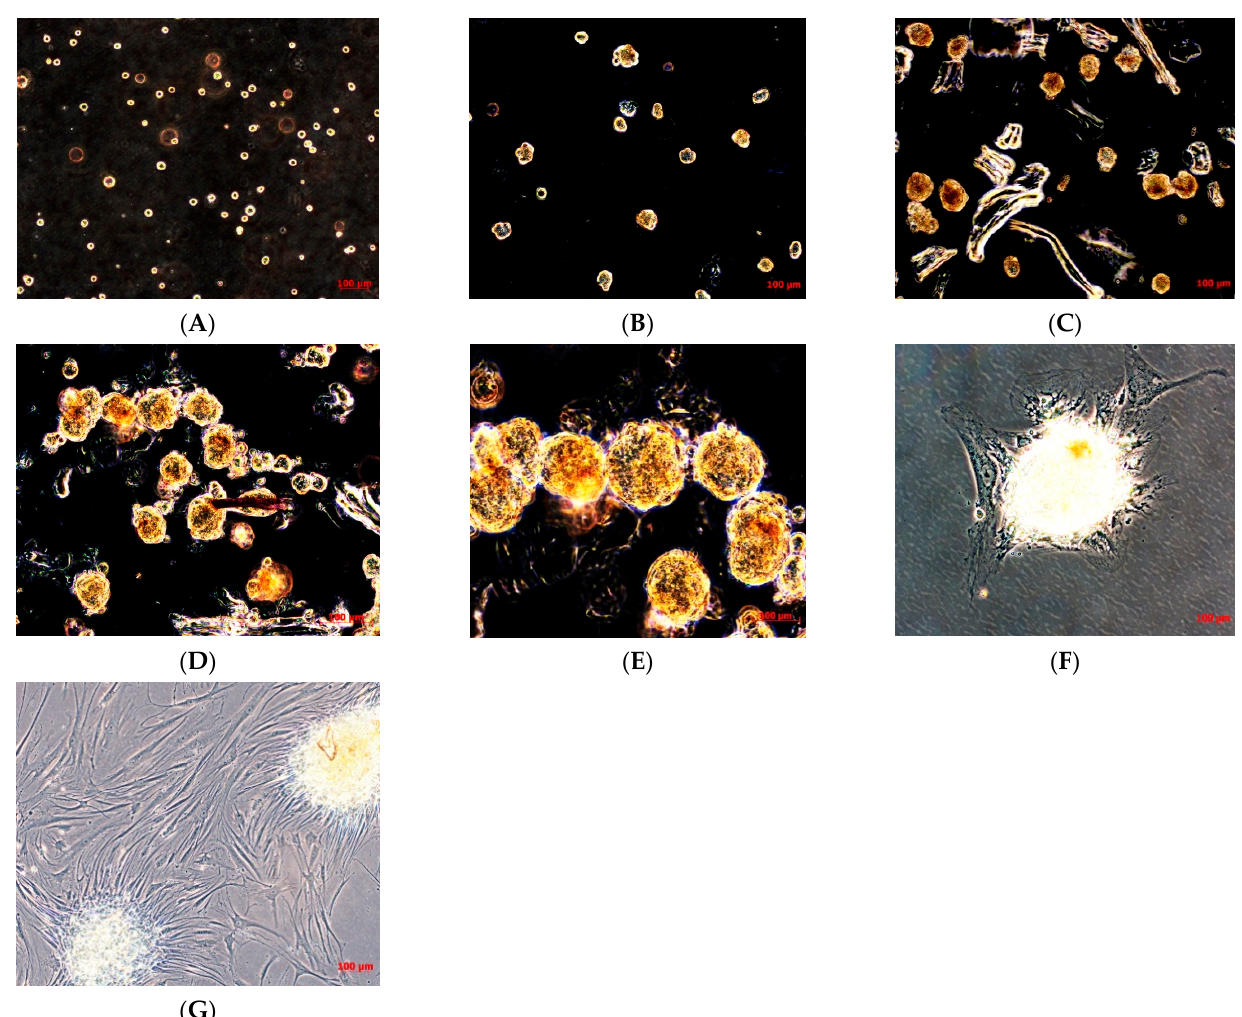
Figure 2. Sarcosphere formation assay on TOS and sarcosphere adhesion. Sarcosphere formation under non-adherent conditions in TOS1 cell line after 24 h ( A ), 7 days ( B ), 14 days ( C ), and 21 days ( D,E ). Sarcospheres from TOS1 cell line showed adherent expansion by reintroduction and reculturing in monolayer, adherent conditions at 48 h from the isolation ( F ) and after 7 days ( G ). Observation in phase contrast. Original magnification 10×-20-40×.